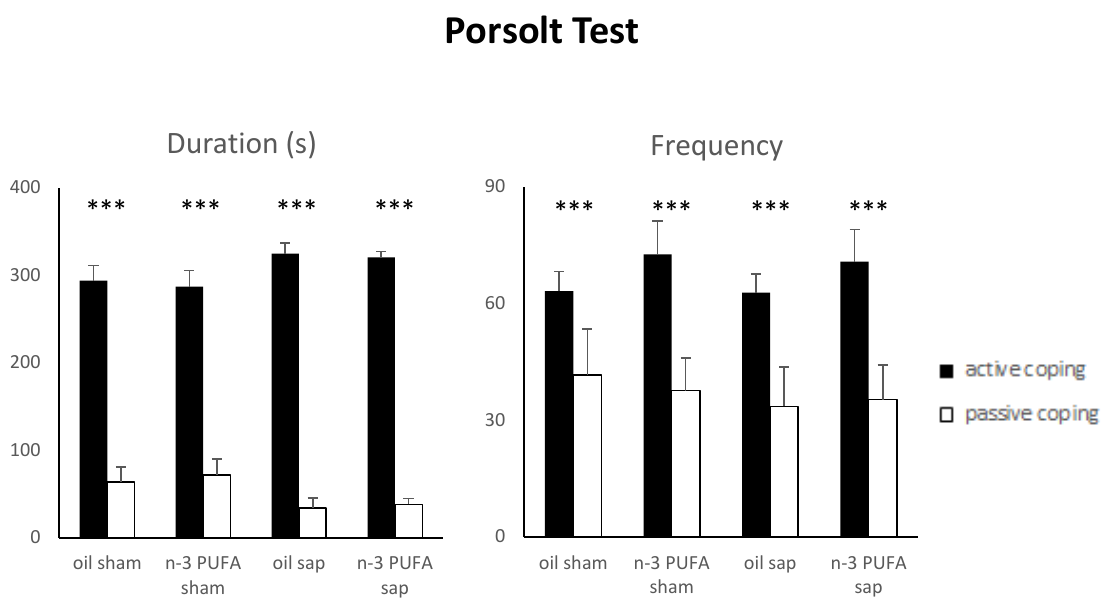
Figure 4. Porsolt Test. Duration and frequency of active and passive coping strategies displayed by the four experimental groups. Data are reported as mean and SEM (oil sham, n = 11; n-3 PUFA sham, n = 10; oil sap, n = 10; n-3 PUFA sap, n = 10). Strategy e ff ect: *** p <